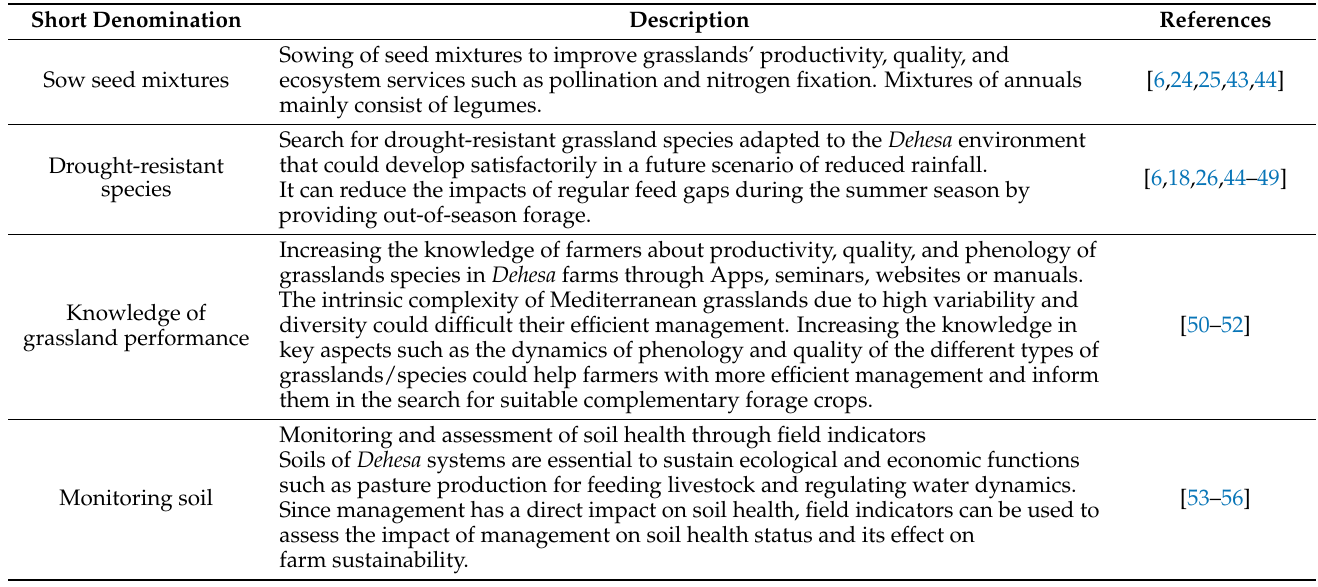
Table 1. Permanent grassland-related innovations selected to be evaluated by the Dehesa